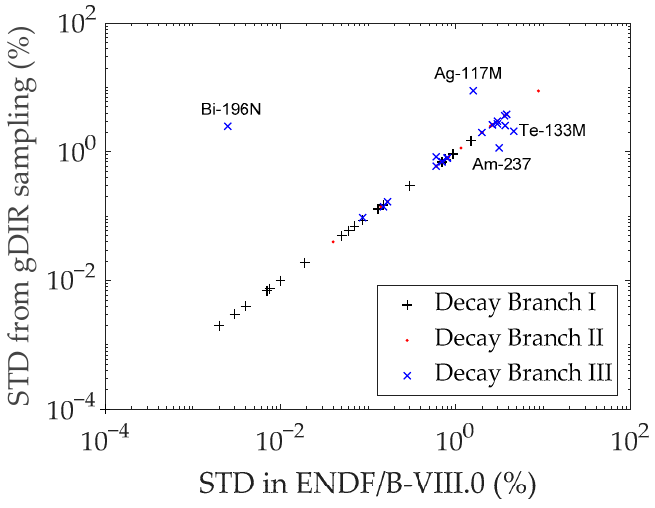
Figure 8. Comparison between suggested STDs in ENDF/B-VIII.0 and estimated STDs from DIR sampling method. (Black “+”, red “.”, and blue “×” are decay branches I, II, and III, respectively; STD means standard deviation; Outliers are observed in the estimated branch ratio STD of branch